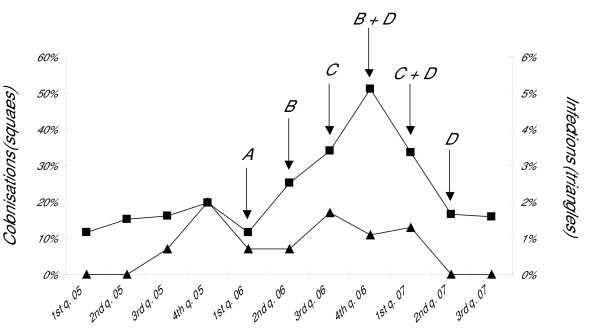
Timing of control measures and incidence of isolation of P. aeruginosa in the NICU during the study period. Squares and triangles represent neonates colonised or infected by P. aeruginosa, respectively. The following letters indicate the infection control interventions performed: A, alert surveillance for P. aeruginosa, collection of strains isolated from clinical samples, and reinforcement of contact isolation precautions; B, environmental microbiological sampling; C, reporting of PFGE analyses to staff members; D, thirty minutes daily educational programme on hand disinfection carried out in the ward for one week.